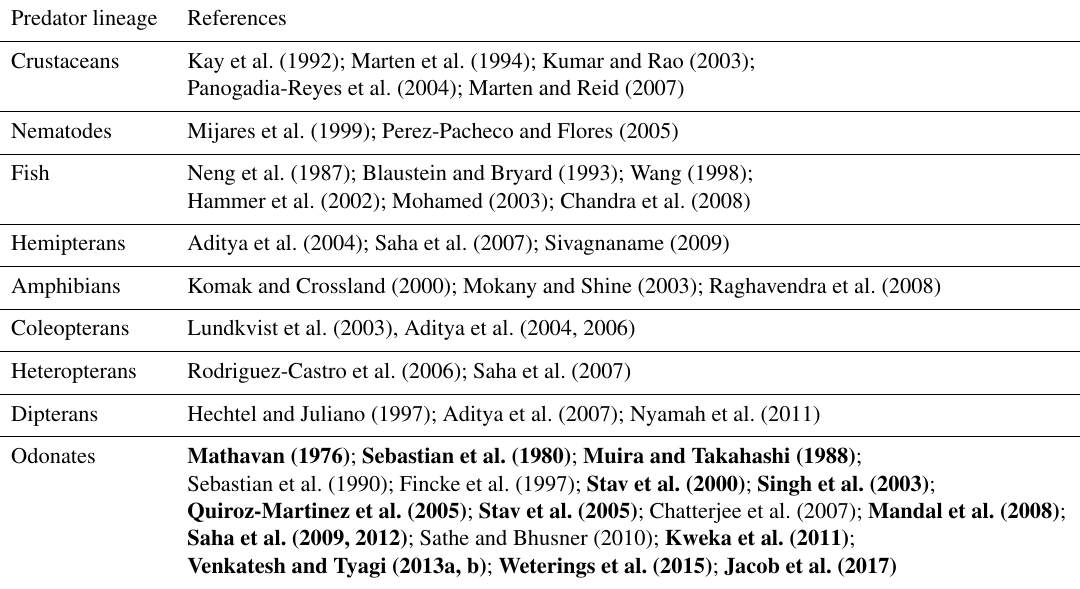
Table 1. List of studies on predator–prey interactions between mosquito larvae and various lineages of predators. Predator